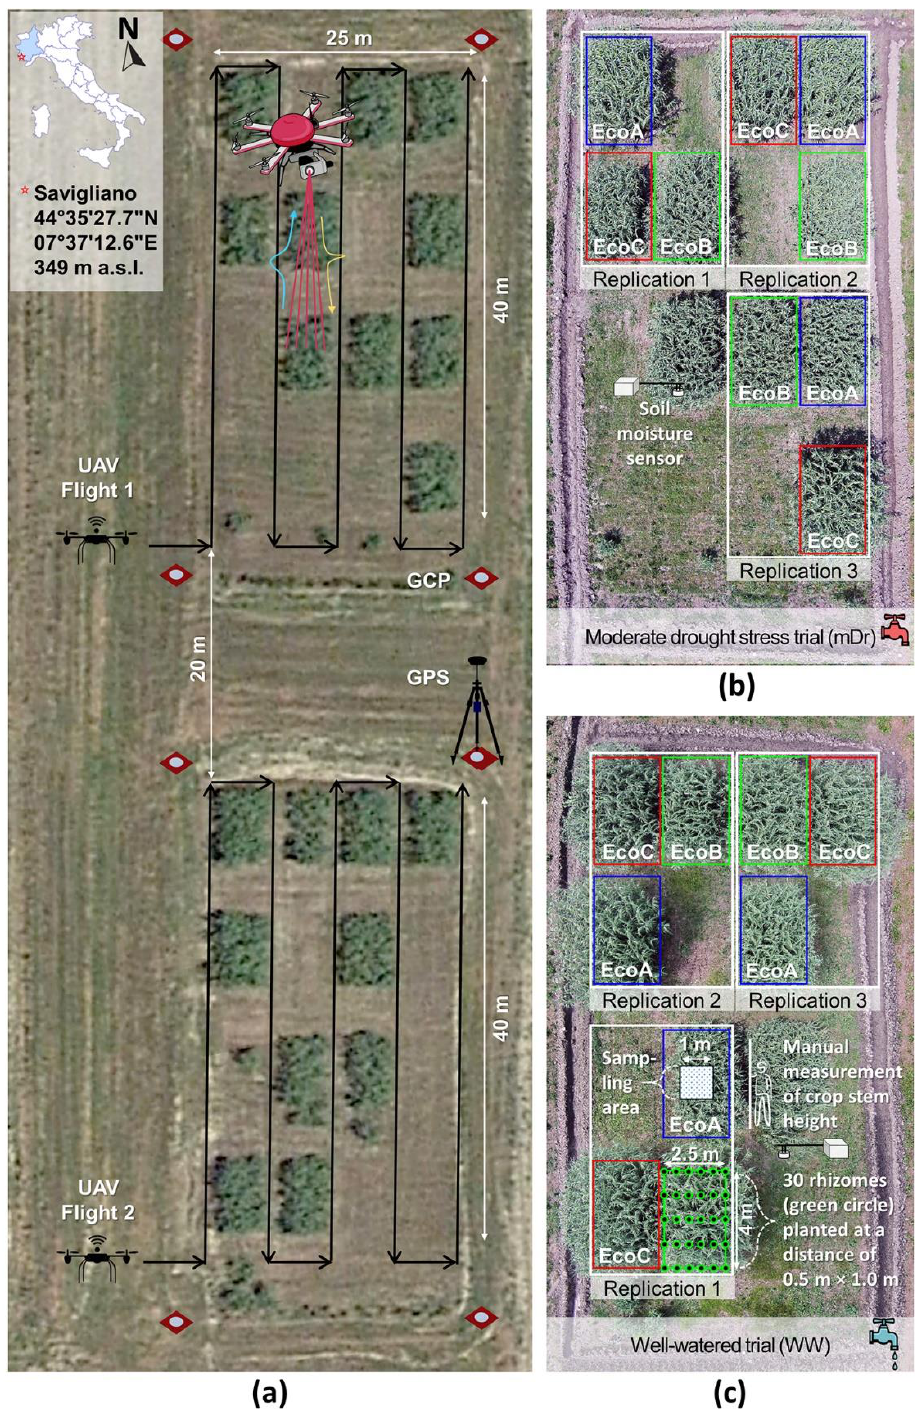
Figure 1. ( a ) Aerial view of the experimental site of Arundo donax located in northern Italy, Savigliano (see inset), with image showing flight plans over the well-watered (WW) and natural moderate drought stress (mDr) treatments (identified in ( b ) and ( c )), running parallel to plant rows to ensure complete coverage with good overlaps. Four ground control points around each plot are also shown. ( b ) Layout of mDr treatment with location of soil moisture sensors. ( c ) Layout of ecotypes and replicates in WW treatment. An example of the central area of one plot used for manual height recording is shown for replication 1 of EcoA (similar positions were used for all plants).